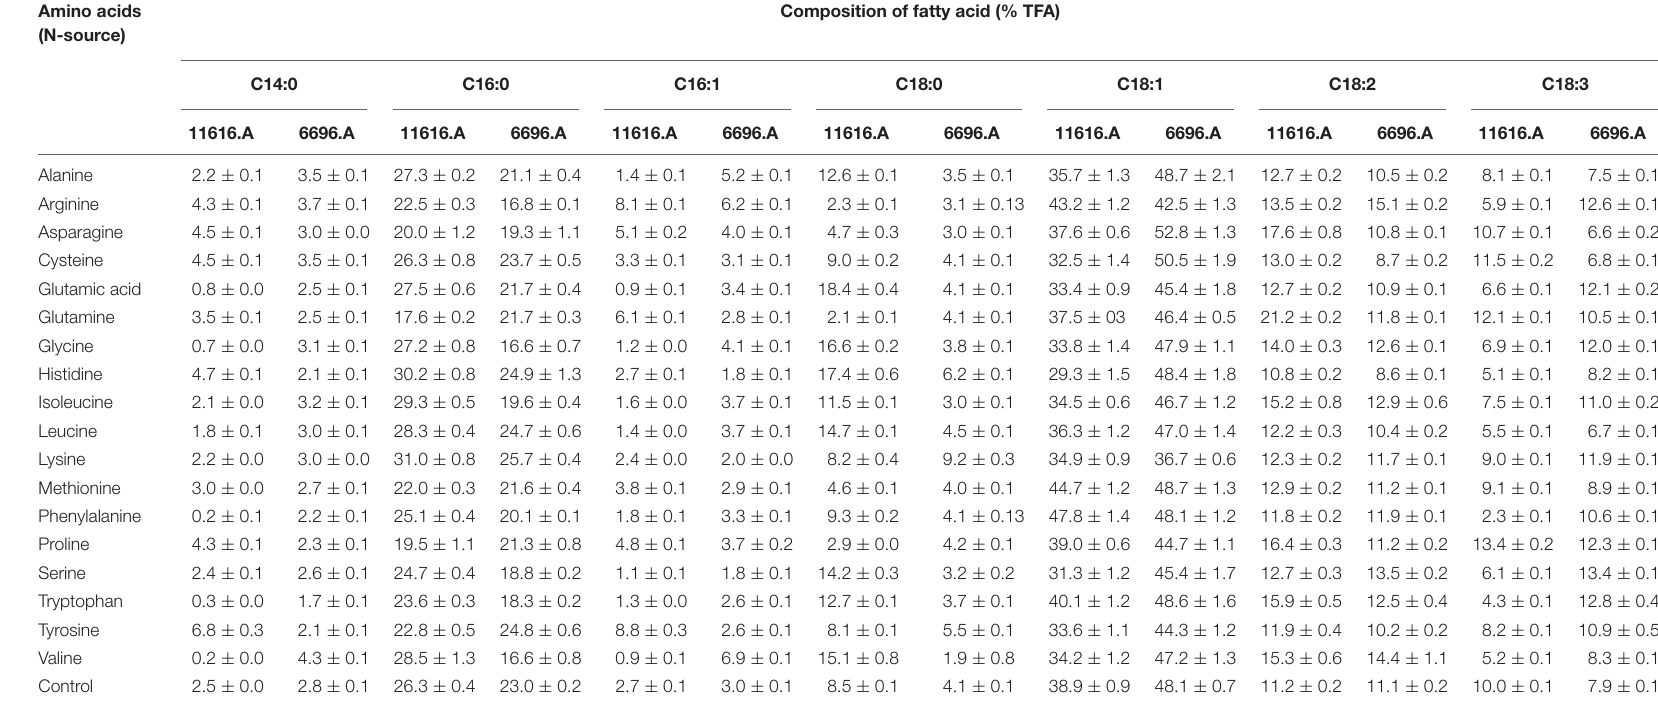
TABLE 1 | Fatty acid composition of R. pusillus AUMC 11616.A and M. circinelloides AUMC 6696.A fungi grown on different amino acids at 28 ◦ C for 4 days. Amino acids